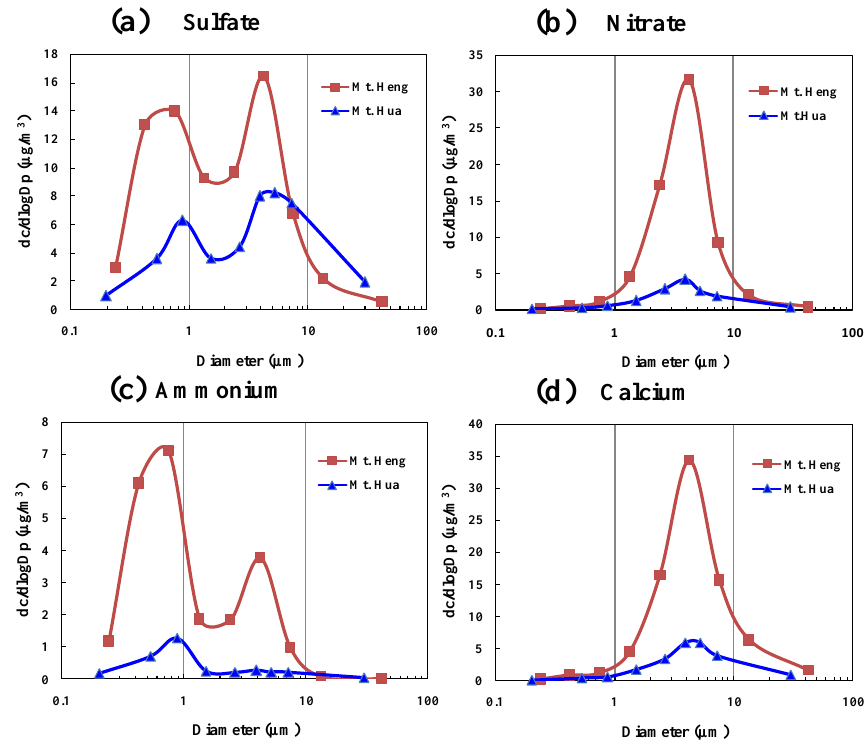
Fig. 4. Size distributions of (a) sulfate, (b) nitrate, (c) ammonium and (d) calcium at Mt. Hua (Wang et al., 2011) and Mt. Heng during the dust event on April 24-26.